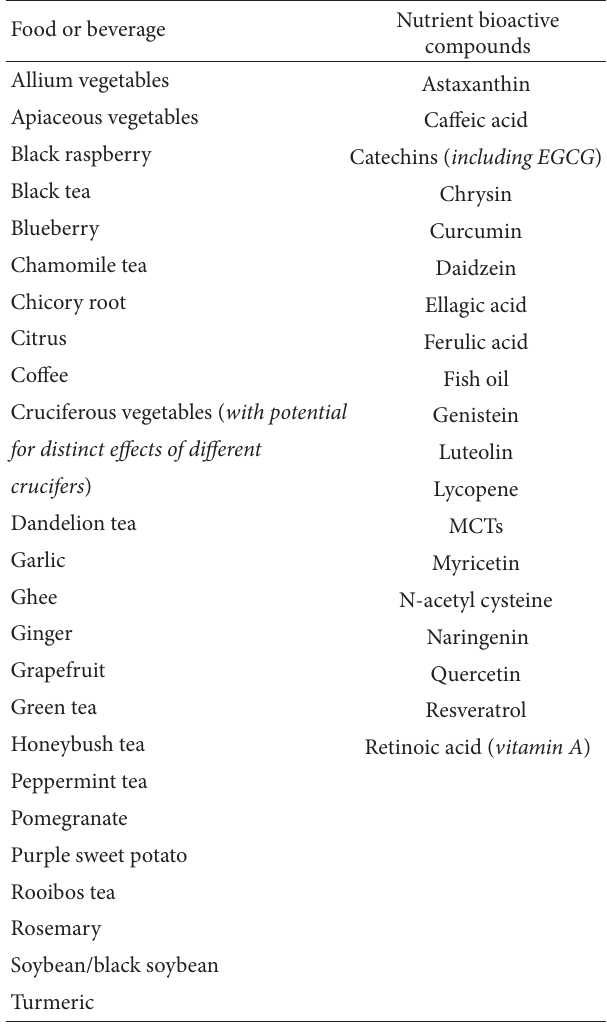
Table 11: Food, beverages, and bioactive compounds with demon- strated, or potential, clinical impact on detoxification